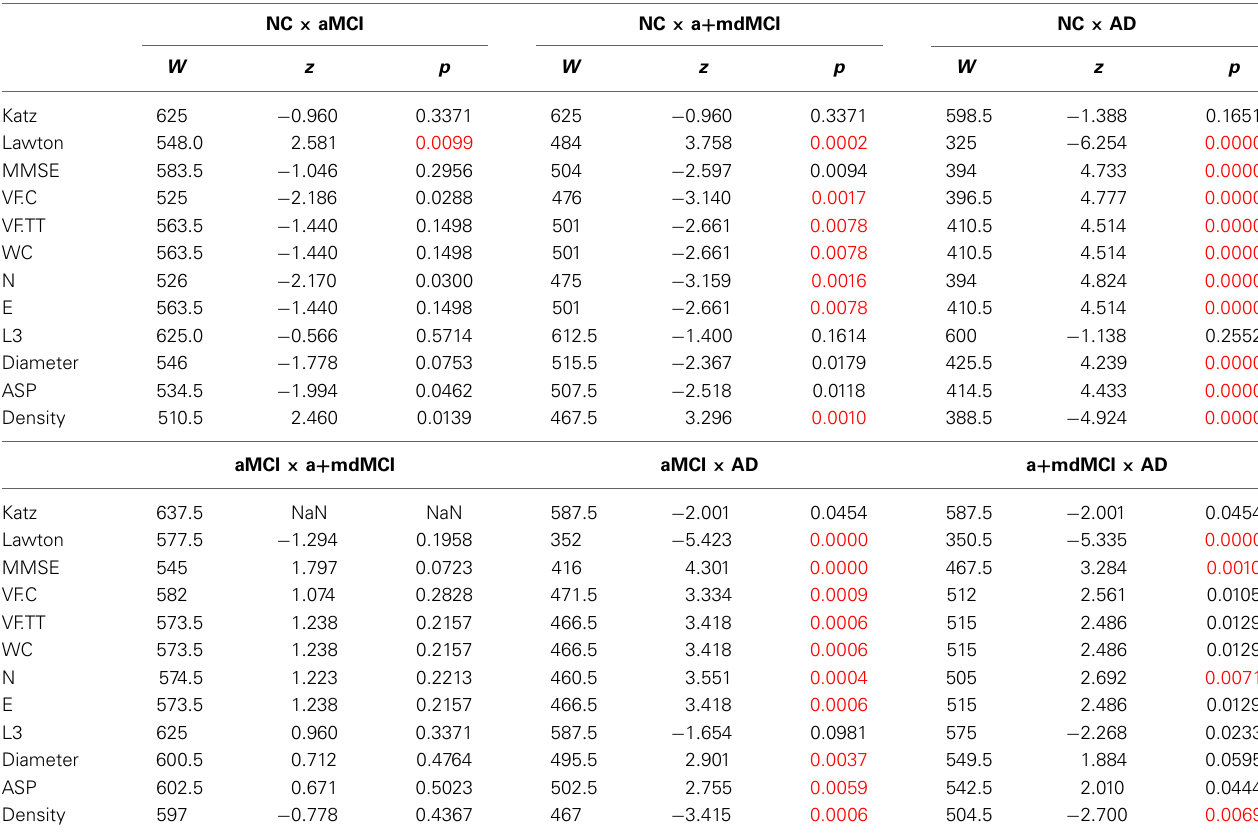
Table 8 | Pairwise group comparison in the variables with significant difference across the four